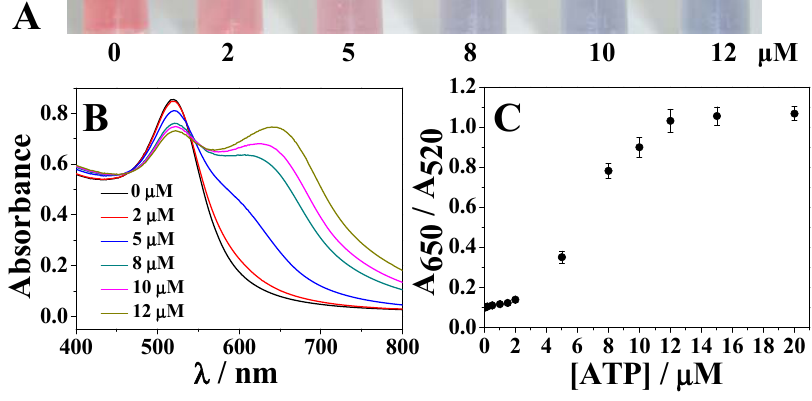
Figure 4. ( A ) Color change with the increase of ATP concentrations. ( B ) Absorbance response for different concentrations of ATP. ( C ) The corresponding plot of A versus ATP concentration from 0, 0.1, 0.2, 0.5, 1.0, 1.5, 2, 5, 8, 10, 12, 15 to 20 μ M.